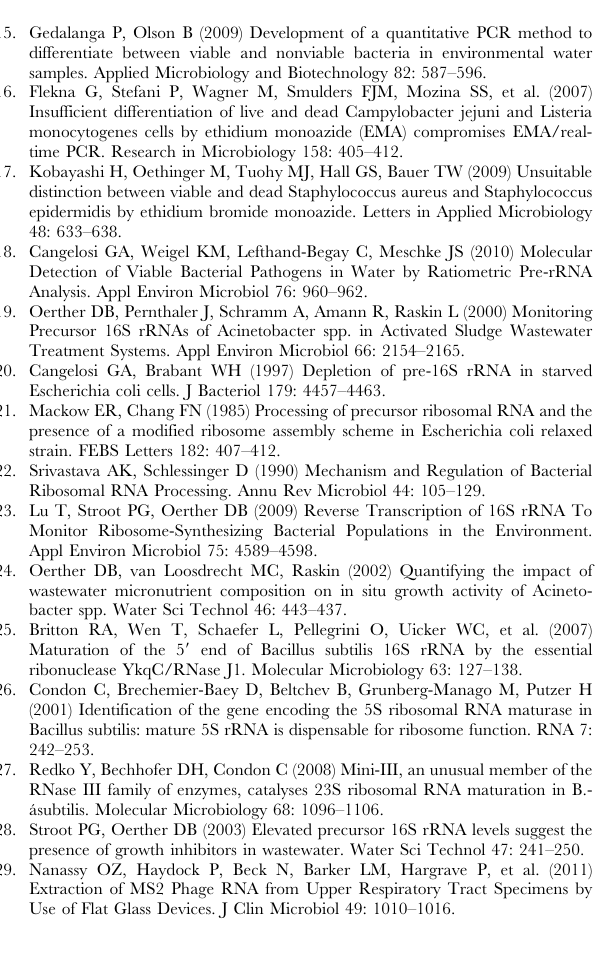
Figure S3 Ratiometric pre-rRNA analysis of A. bau- mannii cells in serum by using a rapid semi-automated approach. Serum-incubated cells were plated to quantify viable CFU/mL, serially diluted in serum, then nutritionally stimulated as in Figure 5. Pre-rRNA was quantified by the rapid proticol used in Figure 5. Values are means and SDs of D Ct values (non- stimulated minus stimulated) from two replicates of each